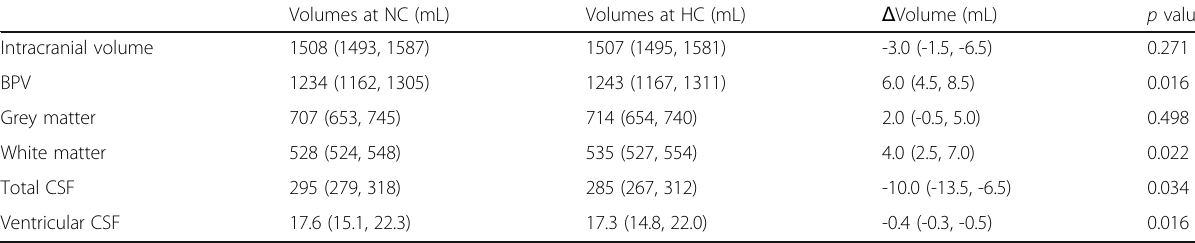
Table 2 Absolute volumes under normocapnia and hypercapnia Volumes at NC (mL)